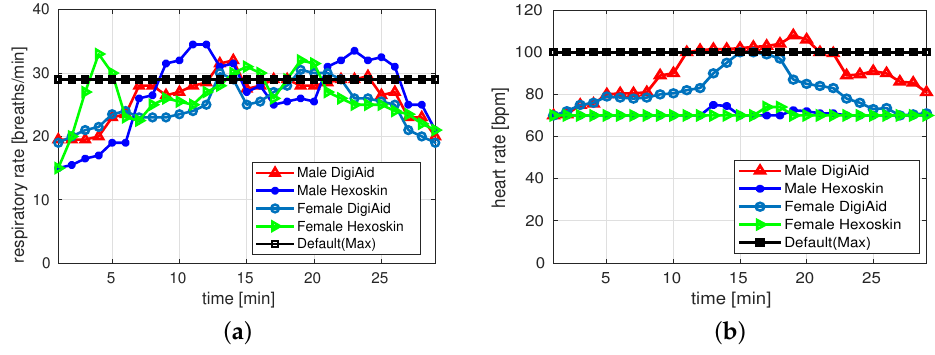
Figure 7. Measurements during walking activity. ( a ) Respiratory rate; ( b ) Heart rate.